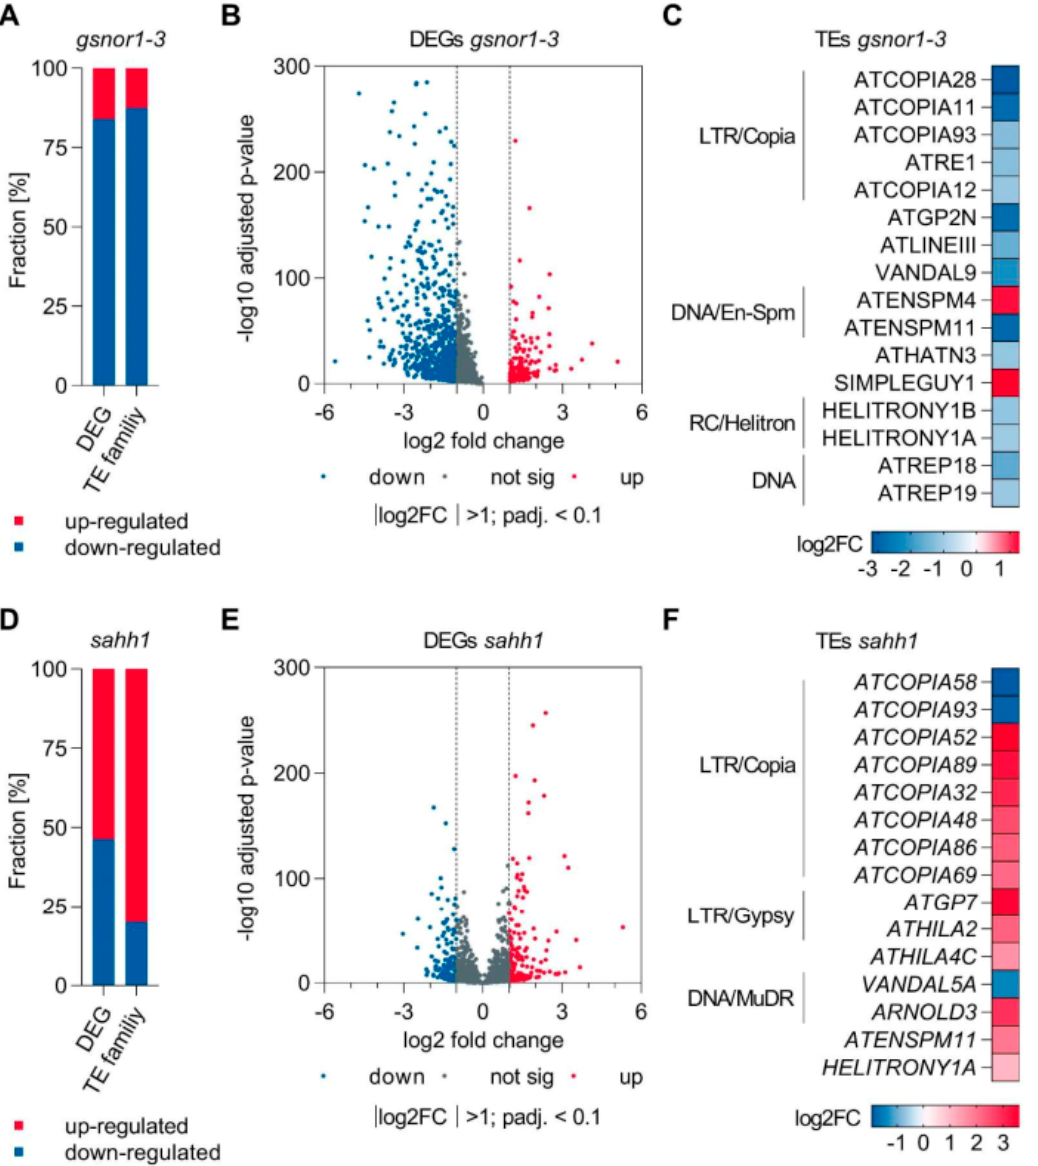
Figure 8. Mutations in GSNOR1 and sahh1 result in transcriptional reprogramming . ( A , D ) Stacked bar plots showing the fraction of significant differentially expressed genes (DEGs) and transposable element (TE) families in gsnor1-3 and sahh1 . ( B , E ) Volcano plot highlighting significant DEGs in gsnor1-3 and sahh1 . Blue and red dots mark significantly decreased or increased expressed genes, respectively. ( C , F ) Heat map showing differential expression of TE families in gsnor1-3 and sahh1 . If more than one family within a superfamily is differentially expressed, superfamilies are indicated. TEs are classified according to www.arabidopsis.org (accessed on 24 December 2018).